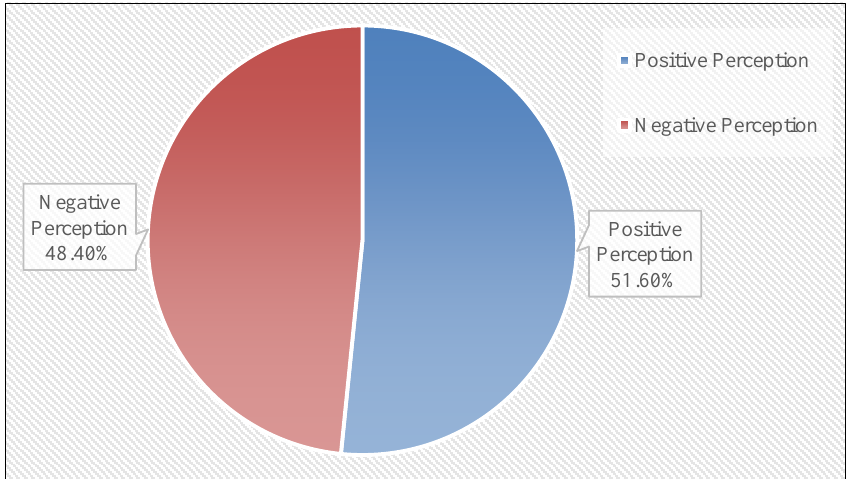
51.60%Negative Perception 48.40%